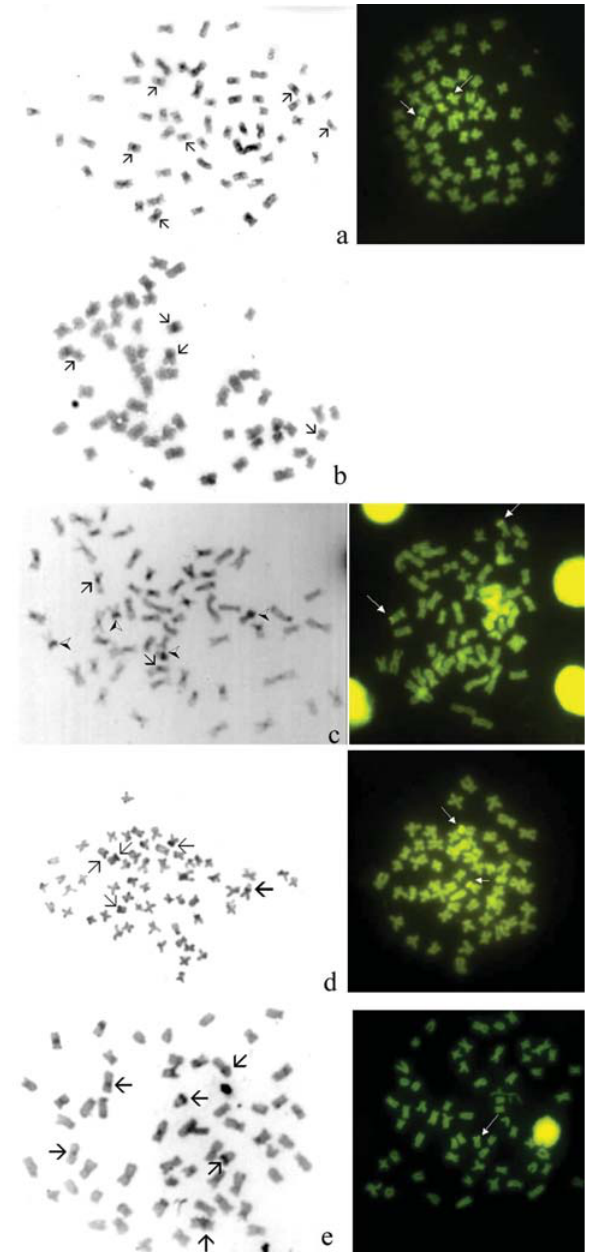
Figure 2 - C-banded (left) and CMA 3 banded (right) karyotypes of the species: a) Hassar cf. orestis ; b) Hassar sp.; c) Opsodoras ternetzi ; d) Hassar orestis ; e) Platydoras cf. costatus . In the C-banded karyotype shown in 2c, the arrows point to centromeric heterochromatin, while the arrow heads show heterochromatic blocks in the short